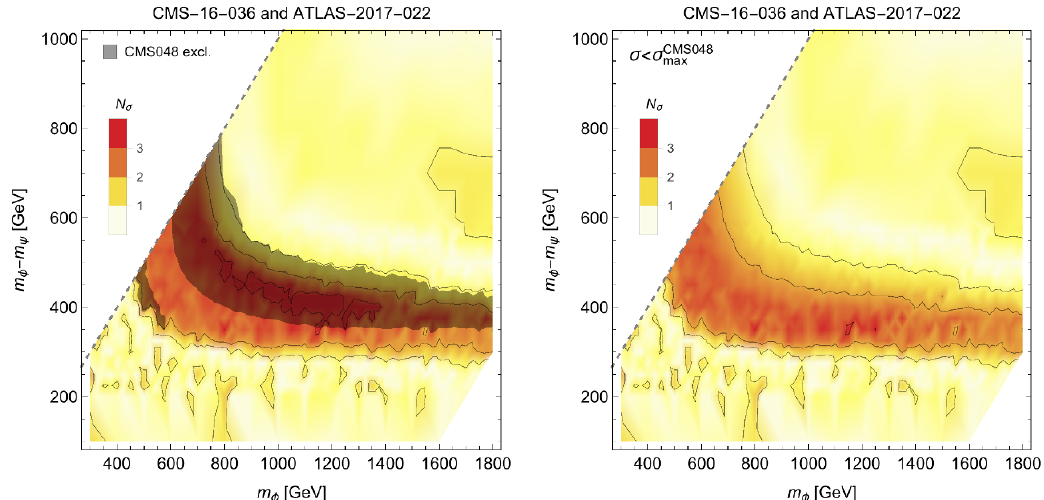
Figure 7 . Limits on the parameter space of the mono- (cid:30) simpli(cid:12)ed model from CMS monojets (CMS048). In the plot on the left, the cross section favored by the combined CMS036 and AT- LAS022 analyses is excluded by CMS048 at the 95% C.L. in the dark gray region. On the right, we show the maximum signi(cid:12)cance of the combined CMS036 and ATLAS022 analyses allowed by